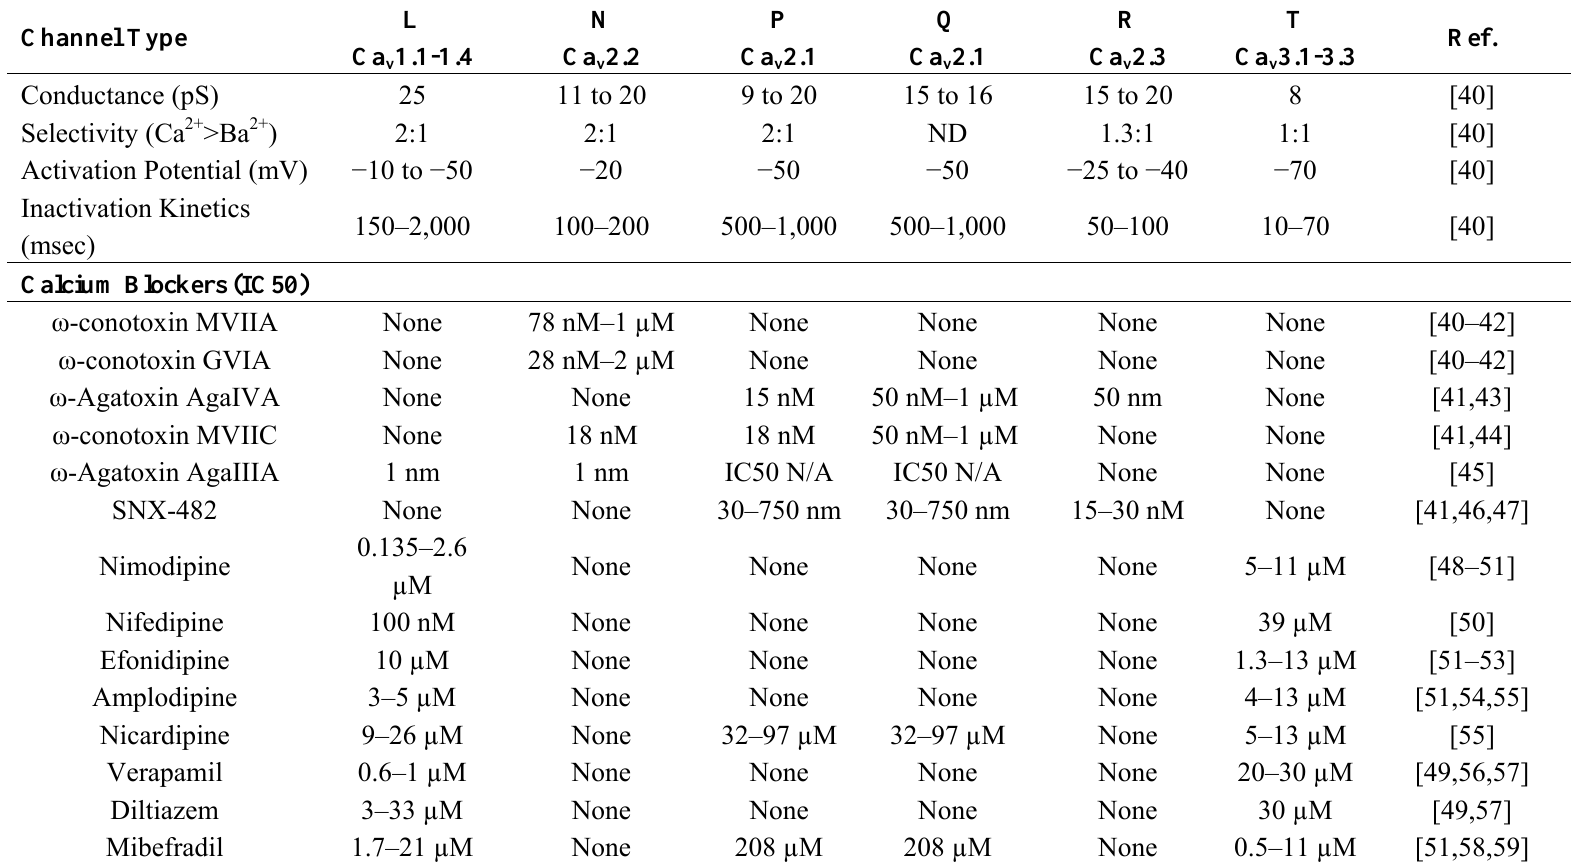
Table 1. Summary of the properties and common antagonists of voltage-gated calcium channel blockers. Channel